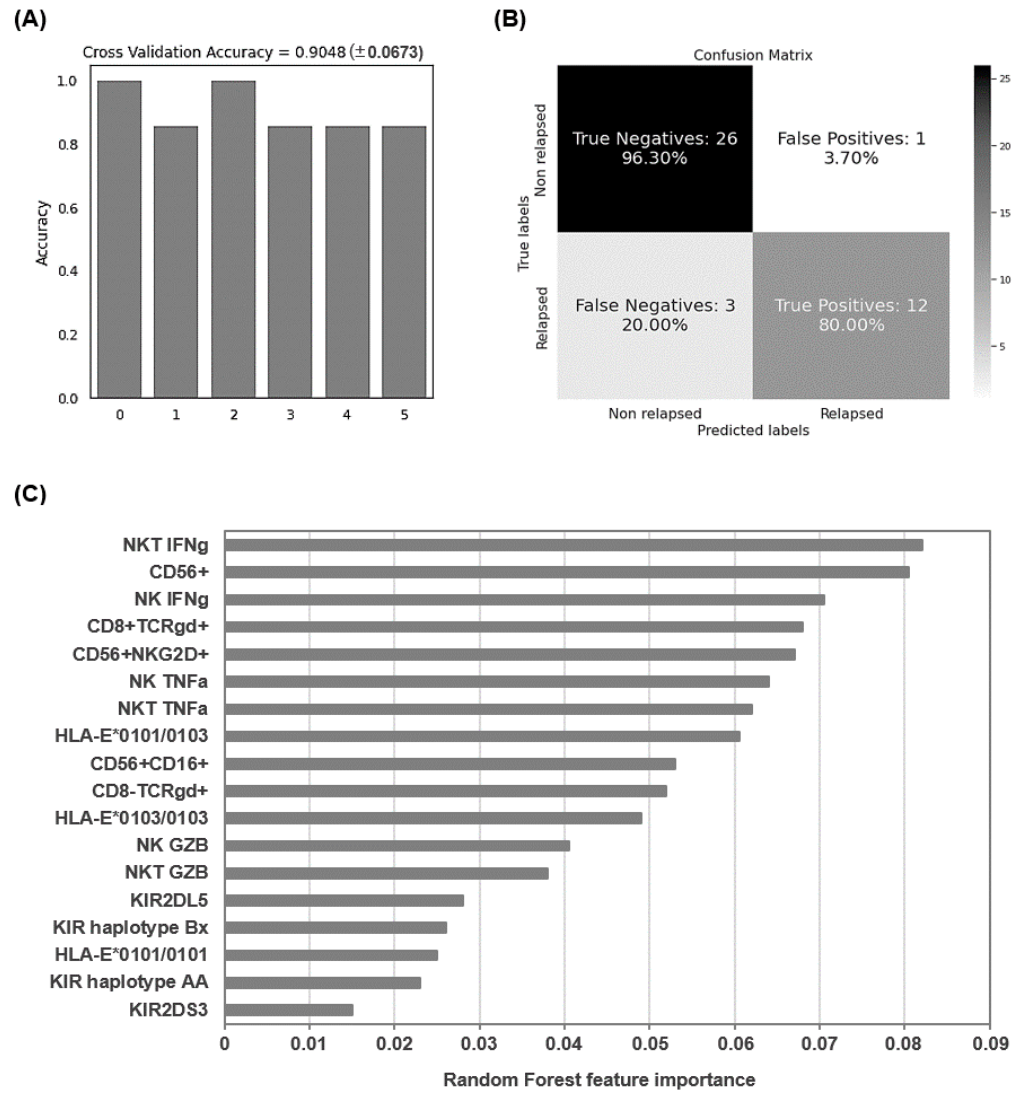
Figure 6. Application of Random Forest algorithm to evaluate the accuracy of the predictive biomarkers of CML relapse. ( A ) Accuracy for the 6 iterations of the outer loop of the nested K-fold cross validation. ( B ) Confusion matrix confronting the true relapse/non-relapse conditions of the patients with CML and the conditions predicted by the algorithm. The Random Forest model predicted 96.3% true negatives and 80.0% true positives, which corresponded to correct predictions of patients who did not relapse and patients who relapsed, respectively. ( C ) The importance of the analyzed features for the categorization of patients with higher likelihood to relapse was analyzed by Gini VIM